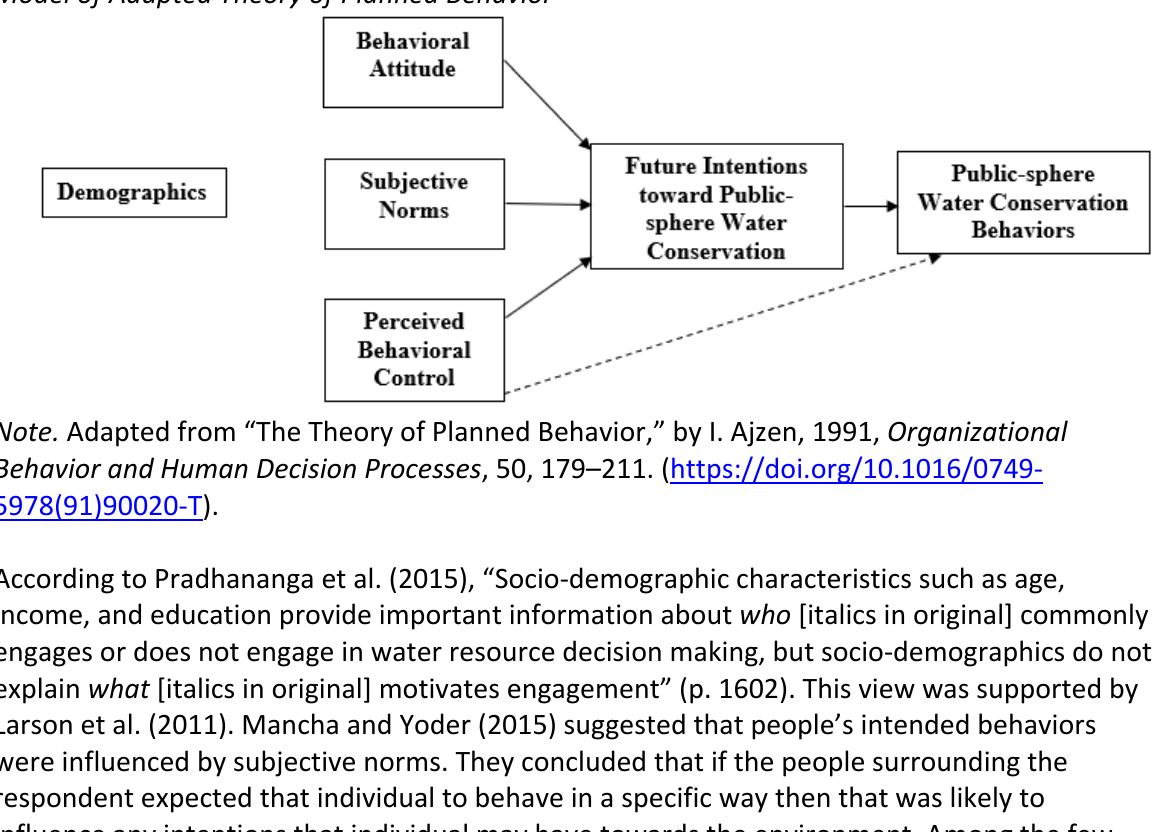
Model of Adapted Theory of Planned